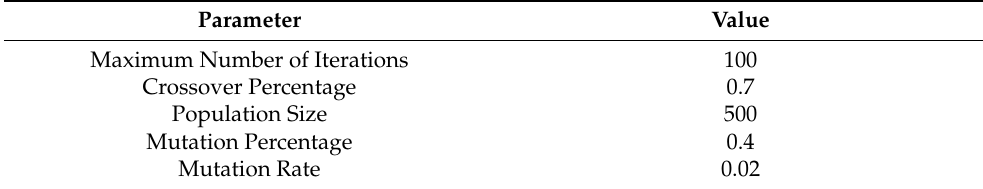
Table 1. Values for controlling parameters of NSGA